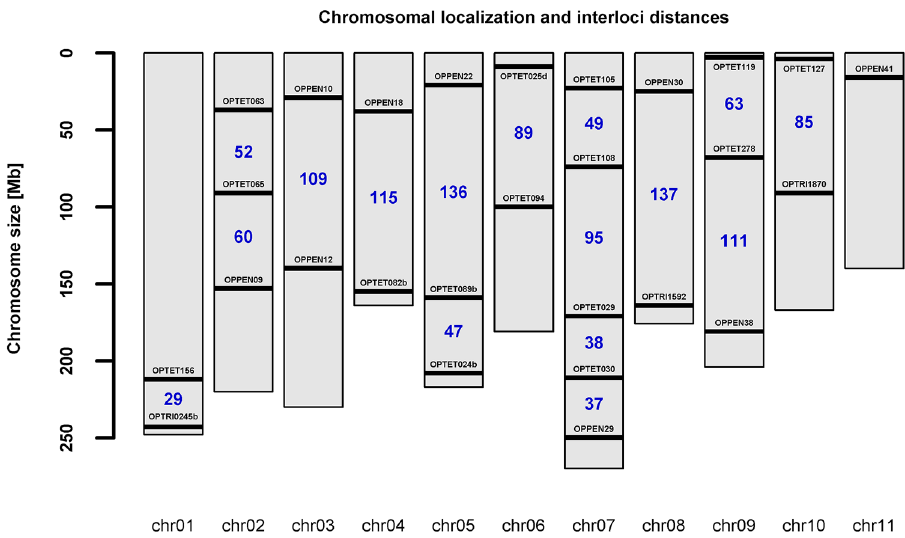
Figure 2. Chromosomal localization of the markers and interloci distances. Created in R v4.0.3 (https:// cran.r- proje ct. org/) 23